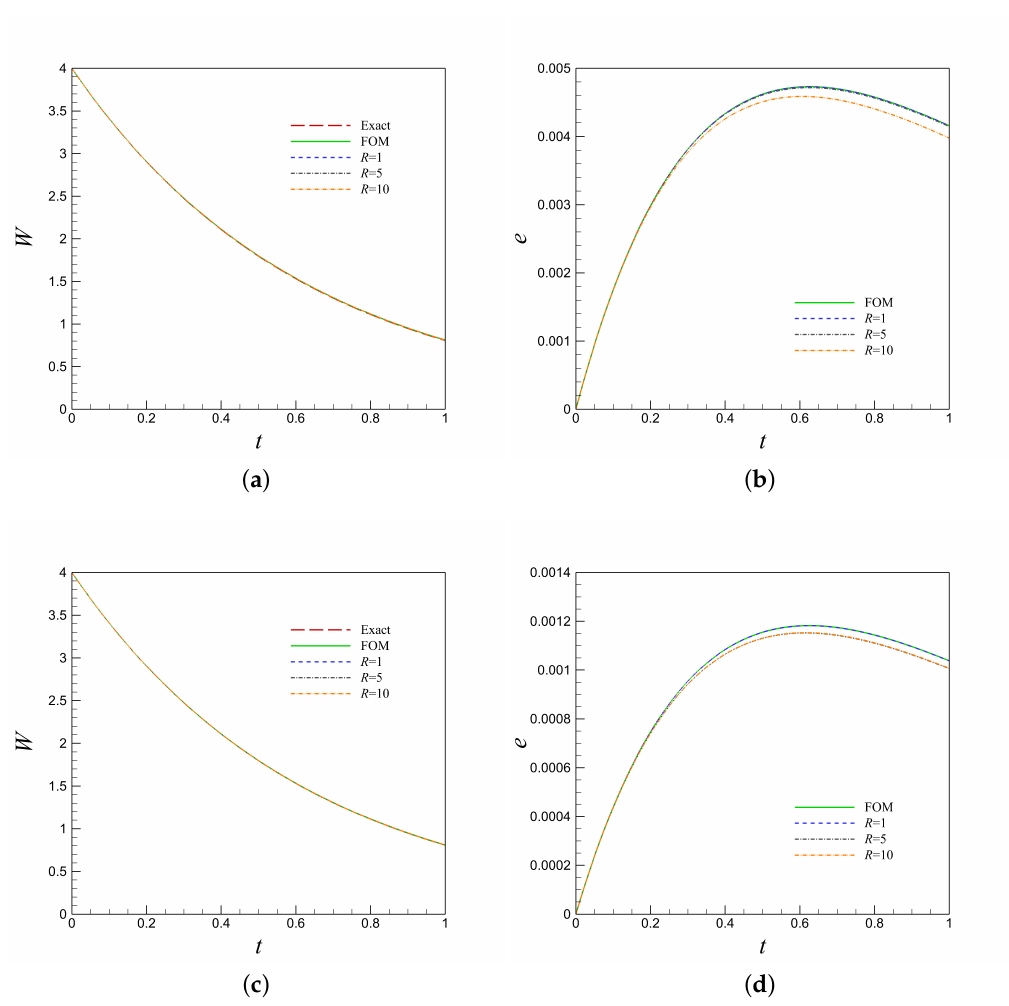
Figure 9. Evolution of the domain integrated total enstrophy for the decaying TGV problem at Re = 10. ( a ) total enstrophy (64 2 ); ( b ) error (i.e., e = W Model − W Exact e = W Model 128 2